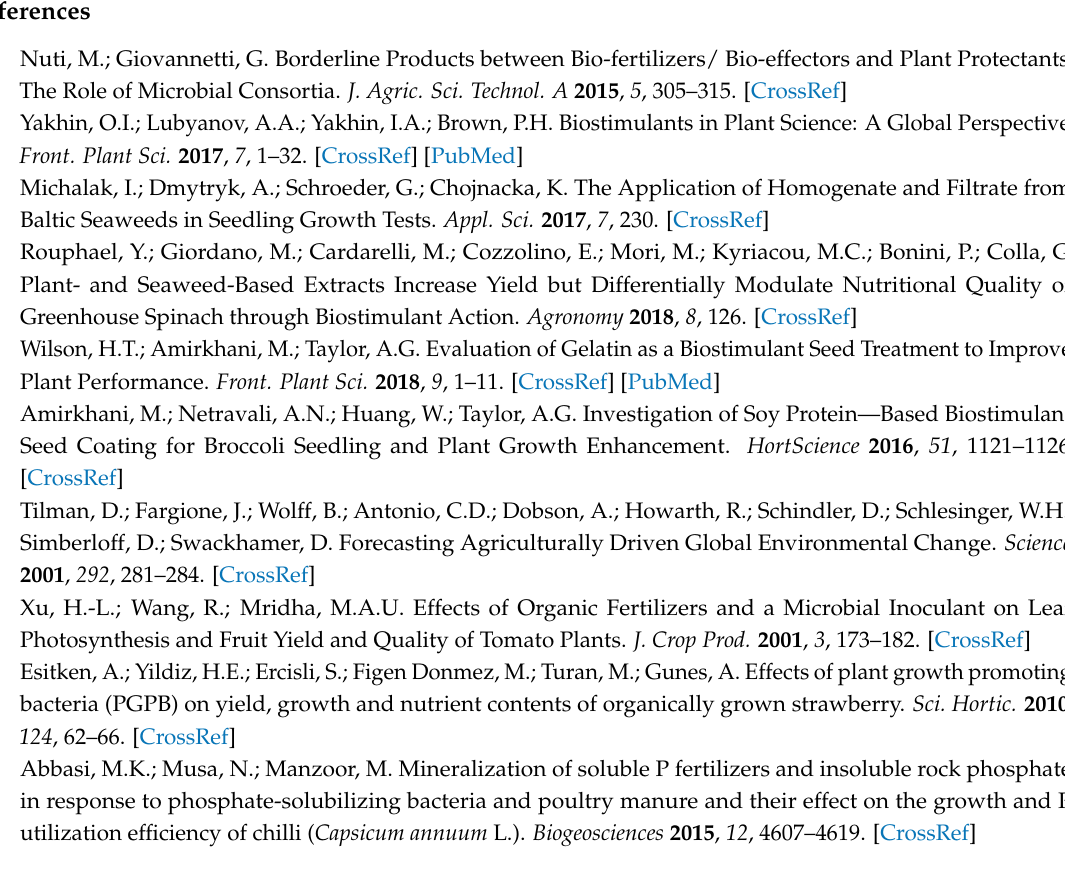
Figure S1: Climate parameters (air temperature 0.5 m above ground, relative air humidity, and radiation) during the experiment in Ramat Hanegev, Israel; Figure S2: Sample rarefaction curves for soil (a) and root (b) samples; Figure S3: Nonparametric multidimensional scaling (nMDS) analysis of root-affected soil (a) and rhizoplane (b) microbiome; Table S1: Substrate properties; Table S2: Fertilization management; Table S3: Application of biostimulants; Table S4: Plant protection; Table S5: Fresh biomass of individual fruits and cumulative fruit biomass production per plant for greenhouse tomato production in Romania with different BS treatments in 2016; Table S6: Three-way ANOVA (P dose, biostimulants, and blocks) on effects of banded P fertilization with DCD-stabilized ammonium sulfate and biostimulants on vegetative shoot and root biomass, root length, P nutritional status, total yield, fruit number per plant (No), and fruit quality distribution of drip-irrigated tomato, Ramat Negev, Israel; Table S7: OTU tables for all soil/rhizoplane samples. In root affected soil, a total of 7815 OTUs were found: 7200 Bacterial, 252 Archaeal, and 363 unassigned. At the rhizoplane, there were 5218 OTUs overall: 4931 Bacterial, 37 Archaeal, and 250 unassigned. Sample names indicate the treatment (Control, MCP, Proradix, FZB421), phosphate level (0, 12.5), and replicate (Rep